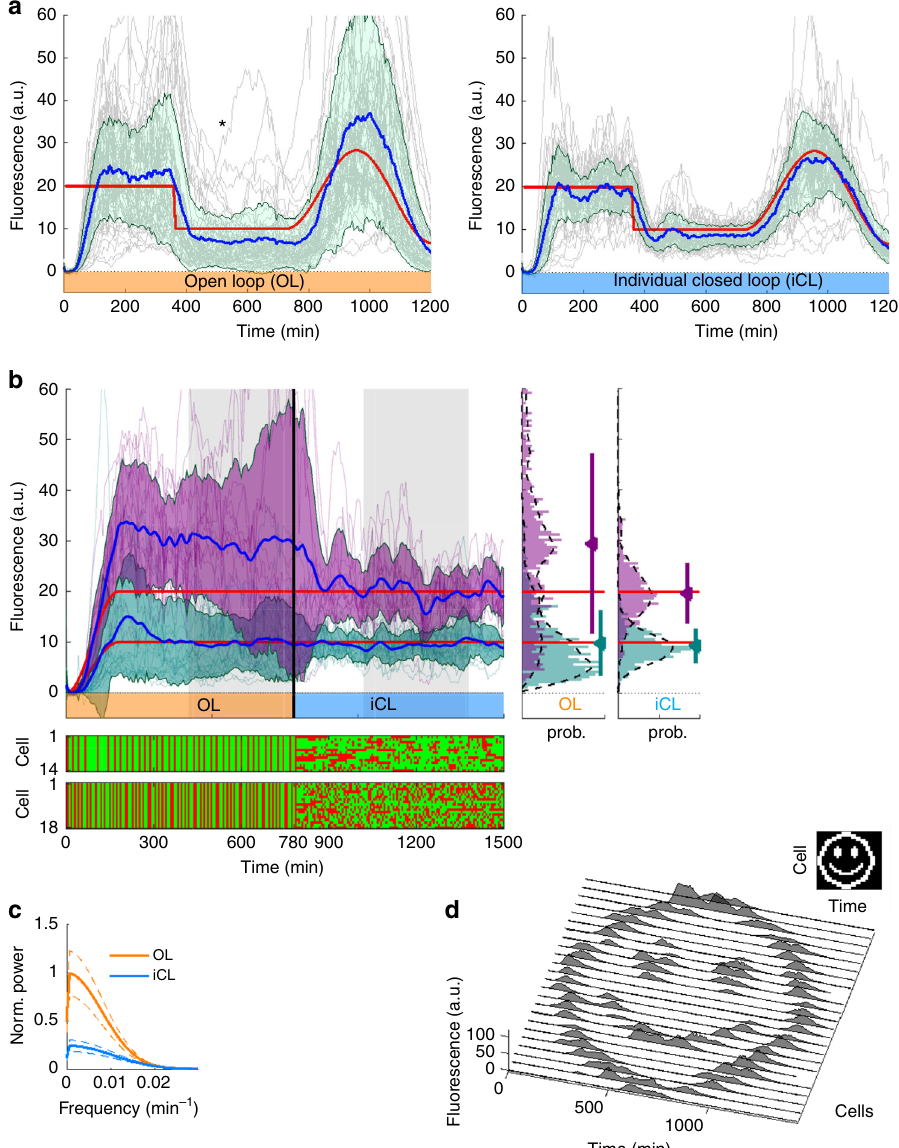
Fig. 3 Specifying gene expression distributions in small bacterial populations using iCL control. a CFP intensity trajectories (gray lines) for individual Escherichia coli cells tracking targets (red lines) under model-based control in either OL (left panel, n = 55 cells) or iCL mode (right panel, n = 49 cells), pooled from two replicate experiments. Deviations of average population trajectories (blue lines) from targets represent errors in control of the mean. Expression distribution breadths (shaded regions, ± 1 s.d.) indicate errors in controlling individual cells. iCL control reduces mean error and cell-to-cell variation, and removes extended excursions in responsiveness seen with OL control (e.g., asterisk-labeled CFP trajectory, Supplementary Movie 3). b Individual CFP trajectories (purple, teal lines) and mean trajectories ± 1 s.d. (blue lines and purple, teal-shaded regions, 1 h moving average) for subsets of cells controlled with targets (red lines) of 10 a.u. or 20 a.u. ( n = 18, 14 cells, respectively). All cells switch from OL (orange-labeled time interval) to iCL (blue interval) control at 780 min. Individual light stimulation sequences (green: activation, red: repression) for cells targeted to 20 a.u. (upper sequences) and 10 a.u. (lower sequences) are displayed below the plot. Distributions of CFP levels in OL and iCL regimes (during gray shaded intervals) are shown to the right. iCL control (right plot), resolves cells into target group distributions (purple, teal distributions, smoothed: dashed lines) by reducing large errors between target group means (triangles) and expression targets (red lines), and narrowing individual errors (error bars: ± 1 s.d.). c Average power spectral densities of OL- and iCL-controlled (orange, blue) fl uorescence trajectories (in gray shaded intervals) in b . iCL control reduces fl uctuations at frequencies below 0.02 min − 1 . Average power spectral estimates are for 14 mean-subtracted trajectories with constant fl uorescence target of 20 a.u. (spectra are similar for 18 cells targeting 10 a.u.). Dashed lines denote standard error of the mean. d Single-cell temporal patterning of CFP expression in 24 cells over 24 h. iCL control targets are rasters of a binarized image (inset) with fl uorescence levels 0 and 15 a.u. Cells shown are automatically selected by longest-validity (Methods) from eight simultaneous